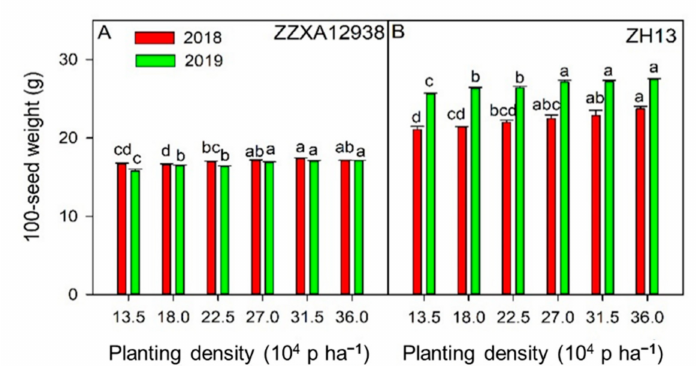
Figure 3. Hundred-seed weight as an effect of planting density and cultivar (( A ): ZZXA12938; ( B ): ZH13). Error bars represent the standard deviation of the mean. Different lowercase letters in the same year indicate significant differences among the treatments ( p ≤ 0.05).